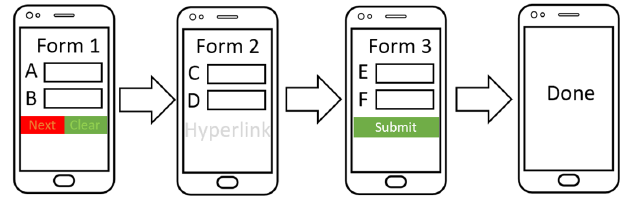
Figure 4. Flow design of the form. Table 2. Training and evaluation datasets.